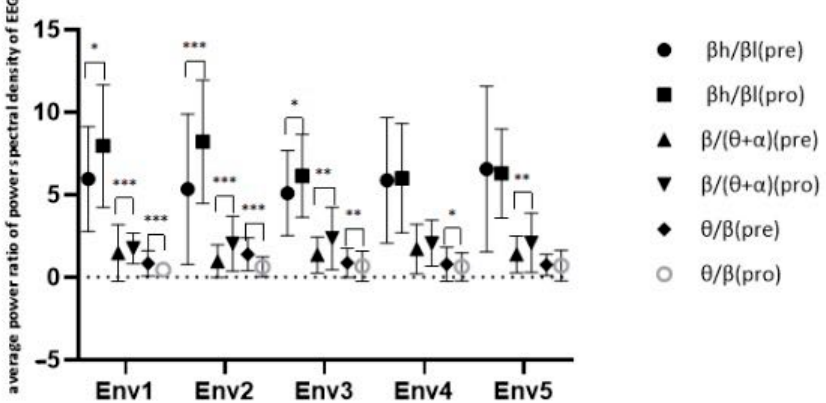
Figure 18. Average power ratio of the power spectral density of EEG. Interpretation: * p < 0.05, ** p < 0.01, and *** p < 0.001. Env1, VR urban environment visual experiencing group; Env2, VR restorative environment visual experiencing group; Env3, VR restorative environment interactive experiencing group; Env4, VR restorative environment with fishing interaction group; Env5, VR restorative environment with watering interaction